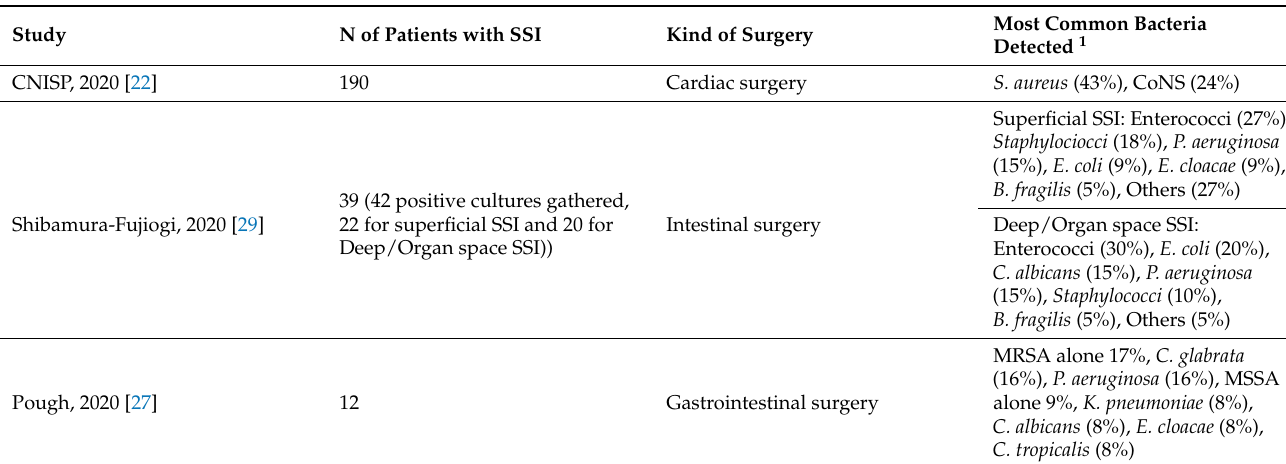
Table 3. Most frequent pathogens involved in pediatric and neonatal